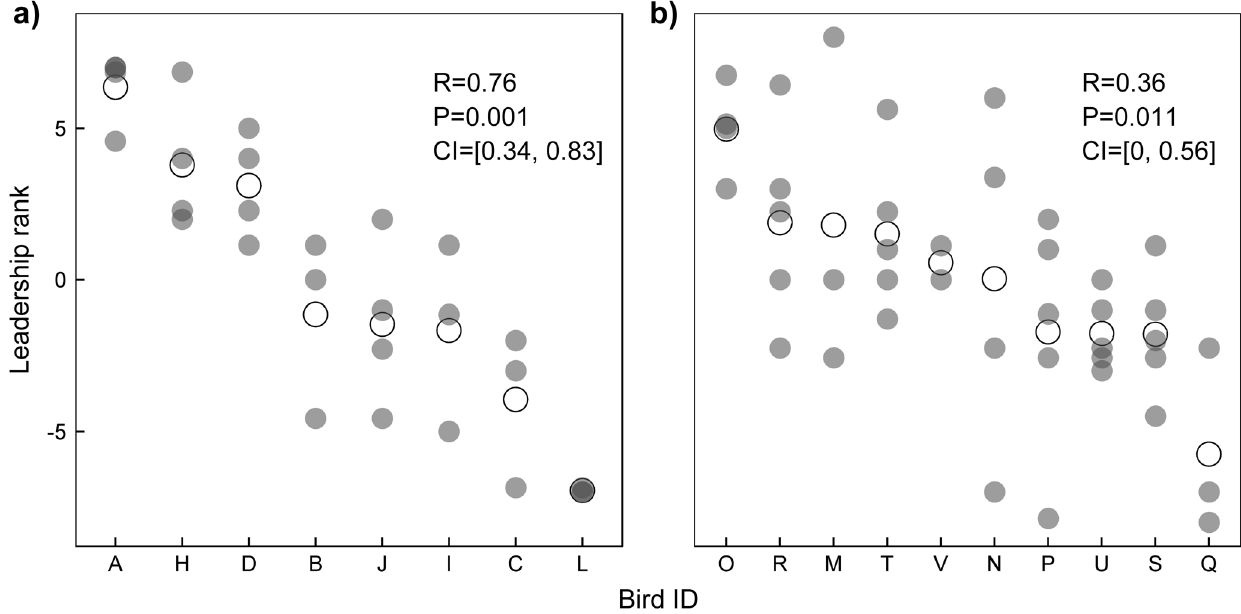
Figure 2. Between-flight leadership consistency. (a) for pigeons with unbalanced homing experience and (b) for pigeons with balanced homing experience. Dots represent individual leadership ranks calculated for multiple flights with the same pigeons. Average ranks per individual are represented by open dots. Leadership consistency can be evaluated from the repeatability of pairwise scores (R). P-values and confidence intervals for R were generated by randomization (1000 permutations) following Schielzeth and Nakagawa